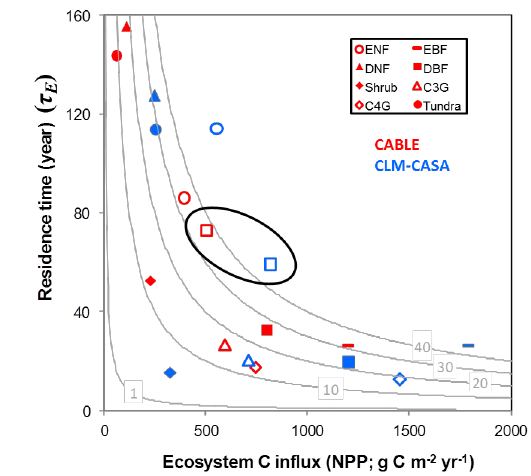
Figure 1. Determination of ecosystem carbon storage (kgCcm − 2 ) capacity (grey contour lines) by carbon influx ( U ss ; x axis) and ecosystem residence time ( τ E ; y axis) (at global and biome level) between CABLE and CLM-CASA (cid:48) . The contour lines show the constant values of ecosystem carbon storage capacity. ENF – ev- ergreen needleleaf forest, EBF – evergreen broadleaf forest, DNF – deciduous needleleaf forest, DBF – deciduous broadleaf forest, shrub – shrub land, C3G – C3 grassland, C4G – C4 grassland. Open squares in the circle show the global values.